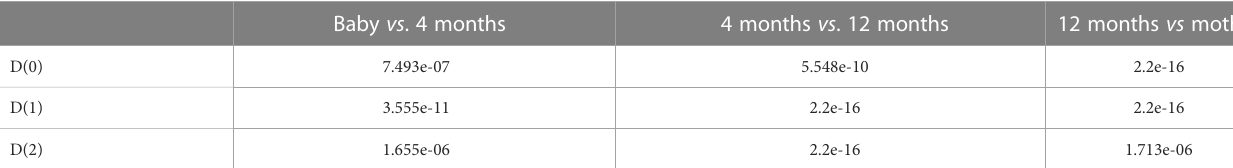
TABLE 3 p -values of the one-sided t -test of dataset 3 (alternative hypothesis: less). Baby vs . 4 months 4 months vs . 12 months